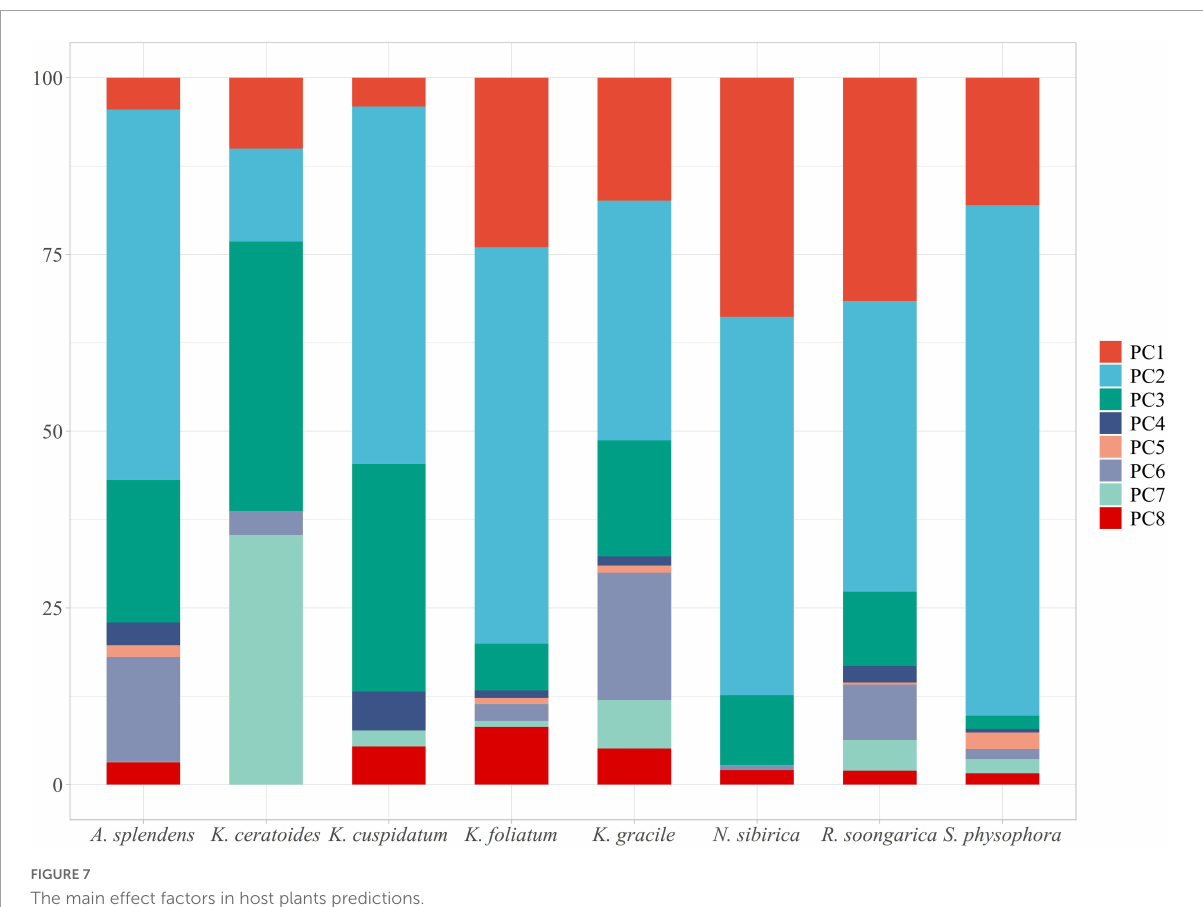
FIGURE7 The main effect factors in host plants